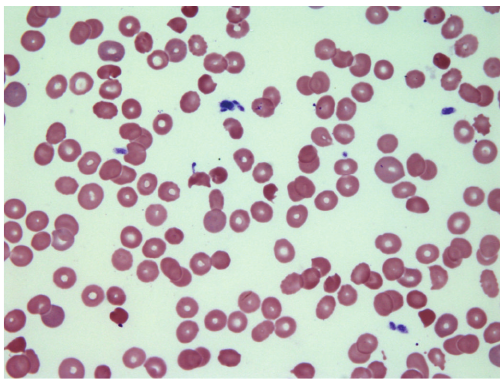
Figure 4: Peripheral blood (Wright Stain, 1000x) showing schisto- cytes, characteristic of microangiopathic hemolytic